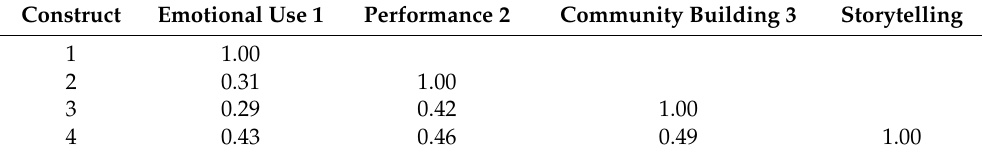
Table 2. Inter-item